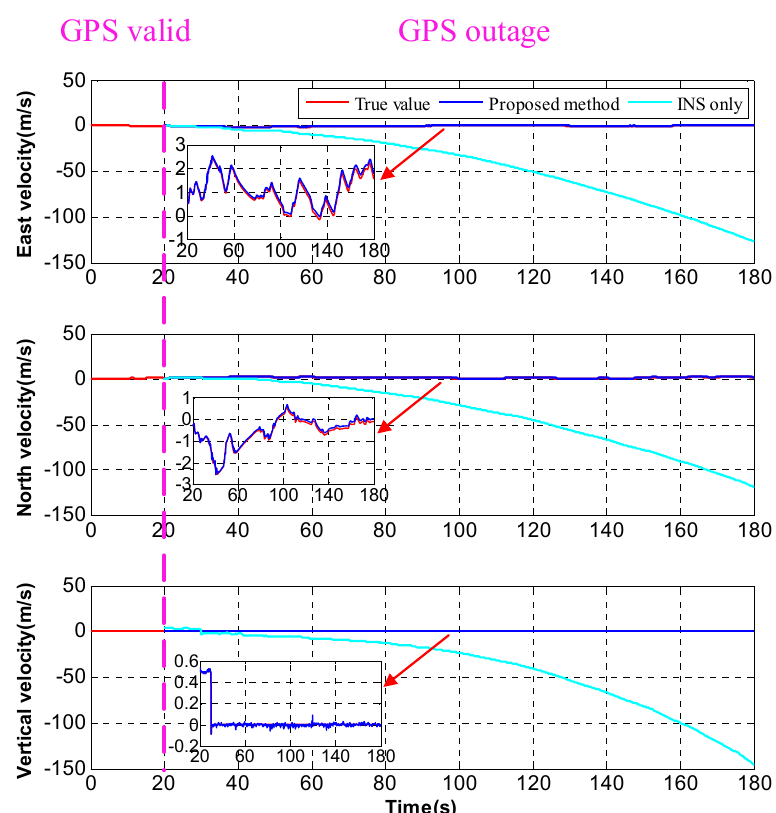
Figure 14. Comparison of velocity results.